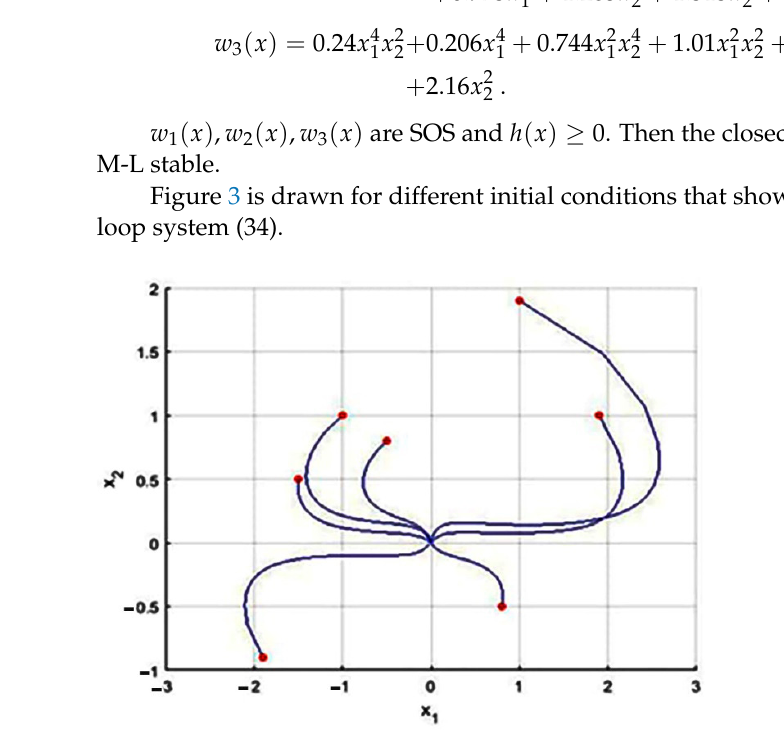
Figure 3. Phase portrait of x 1 ( t ), x 2 ( t ) for PFDE nonlinear system (34). Figure 3. Phase portrait of 𝑥 (cid:2869) (𝑡), 𝑥 (cid:2870) (𝑡) for PFDE nonlinear system (34). Figure 3. Phase portrait of 𝑥 (cid:2869) (𝑡), 𝑥 (cid:2870) (𝑡) for PFDE nonlinear system (34).